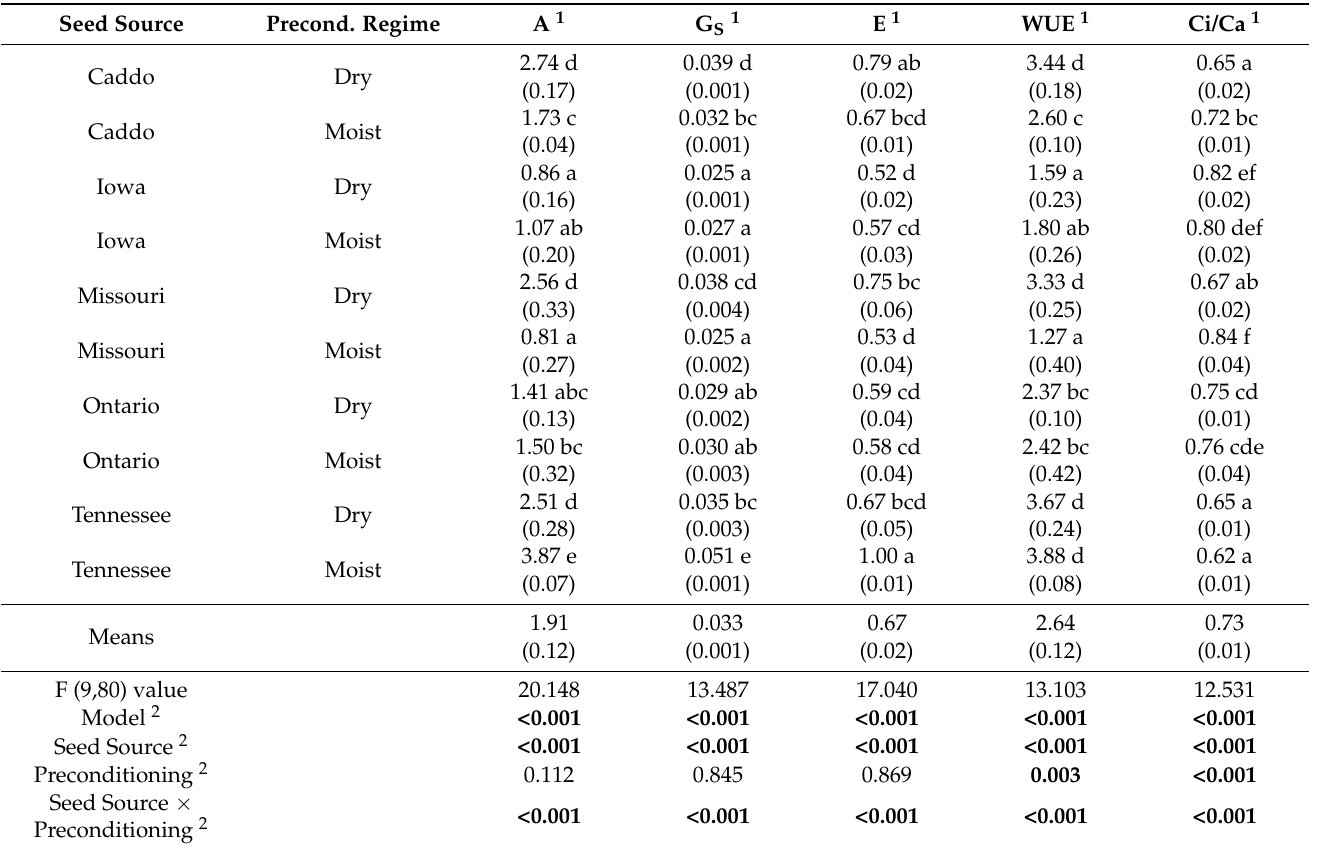
Table 4. Net photosynthesis (A, µ mol CO 2 m − 2 s − 1 ), leaf conductance to water vapor (G S, mol H 2 O m − 2 s − 1 ),